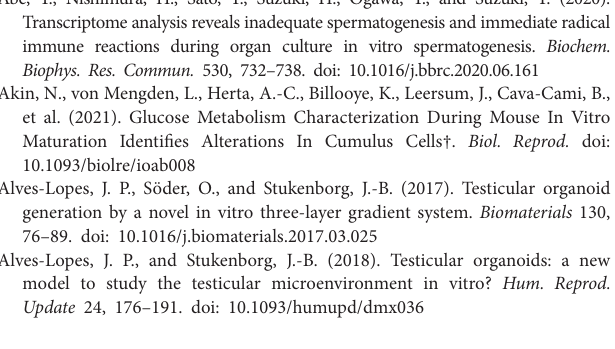
Supplementary Figure 1 | Control immunofluorescent stainings of murine adult testicular tissue. (A) Immunofluorescence analysis of cell death (terminal deoxynucleotidyl transferase-mediated dUTP nick end labeling, TUNEL, A ) and the somatic testicular cells (B–E) and extracellular matrix (ECM; C ) of the SSC niche: